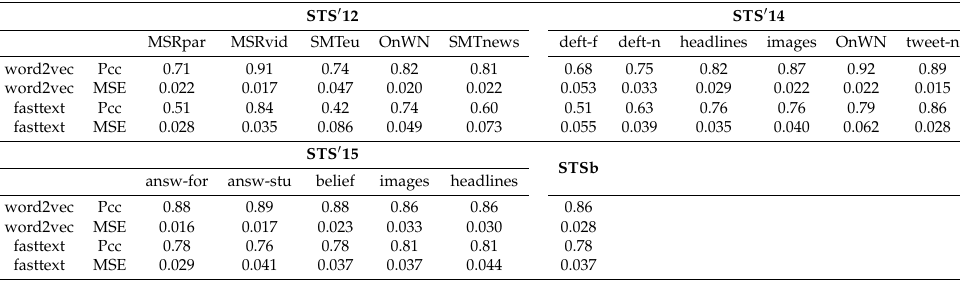
Table 5. The semantic influence of the input word